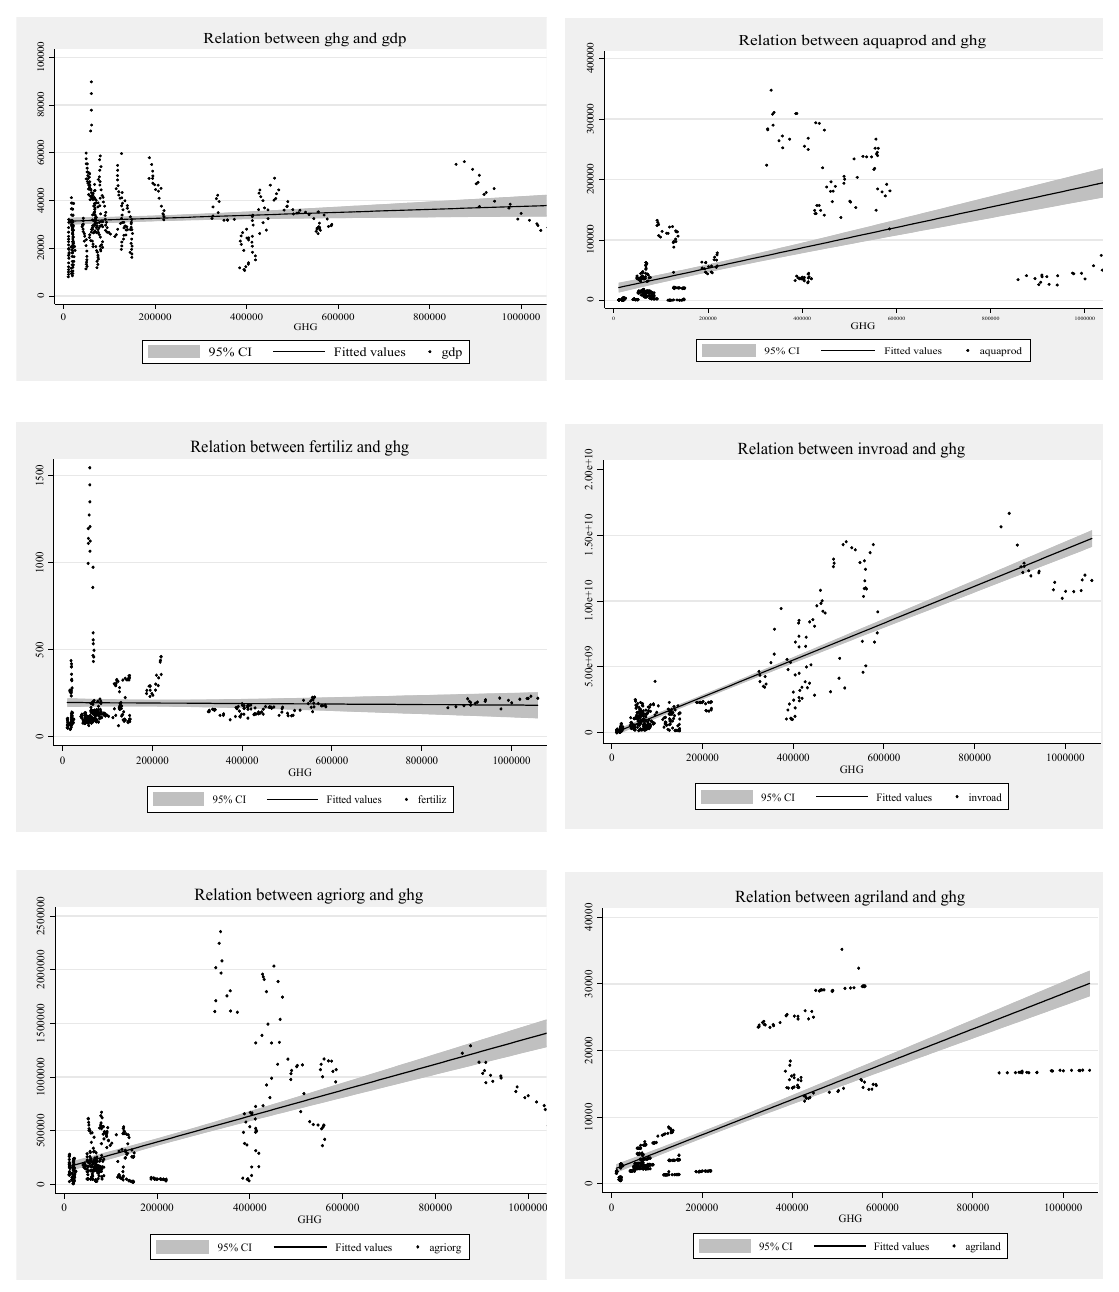
Figure 2. The Relation between Variables.